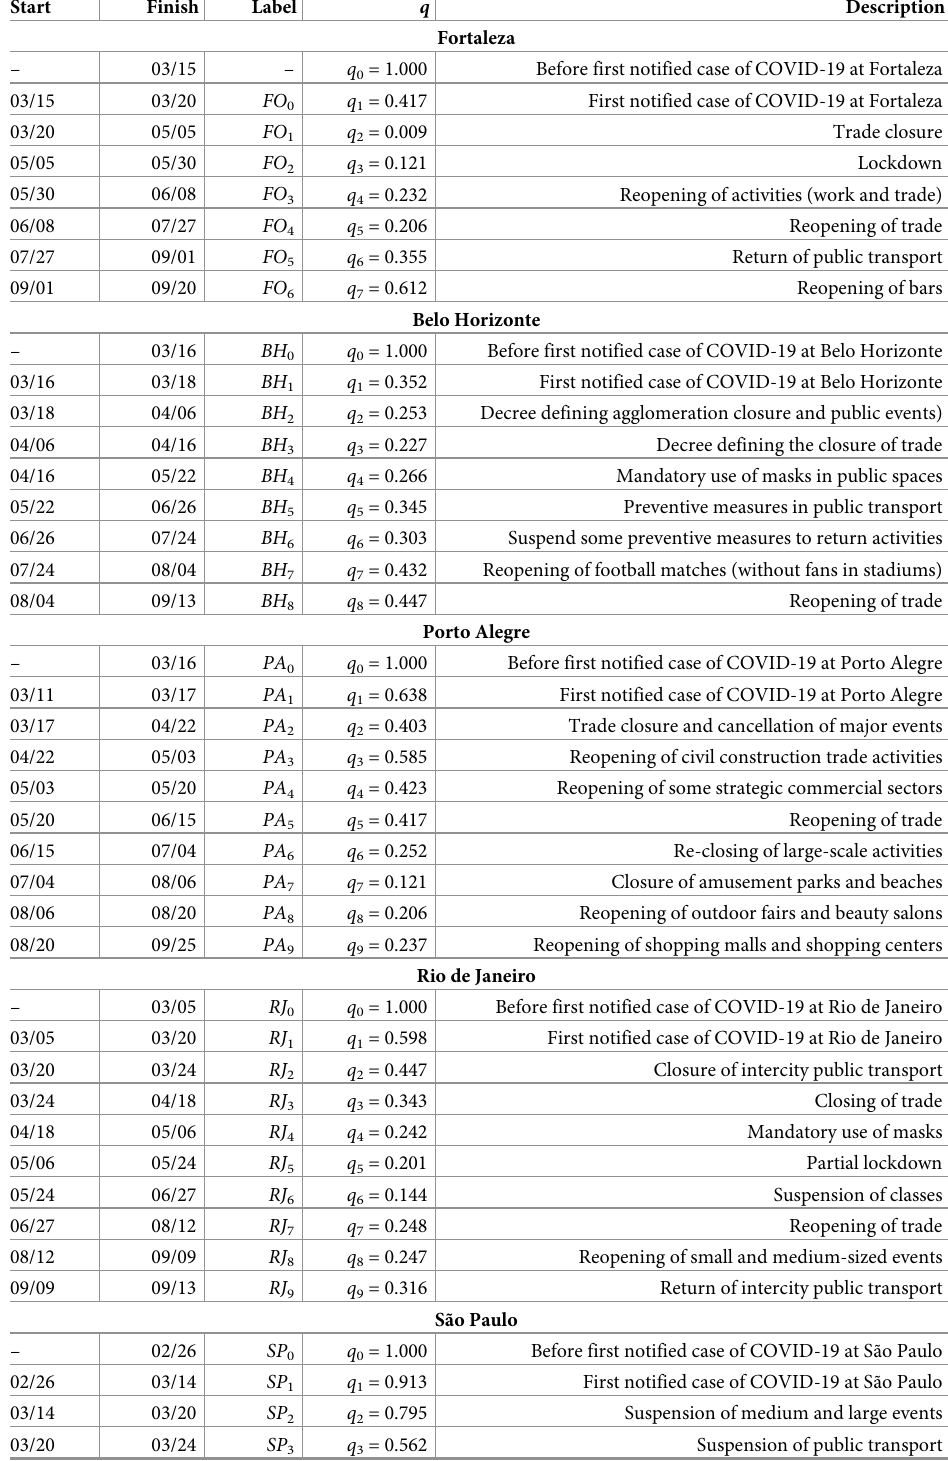
Table 1. Periods used to estimate the mobility parameter q t for different cities. The table presents the periods used in our model to estimate the different values of the mobility parameter q t alongside the q t sample mean. We collected these periods from news provided by the government of each city in 2020. The description describes the main events related to the period. Start